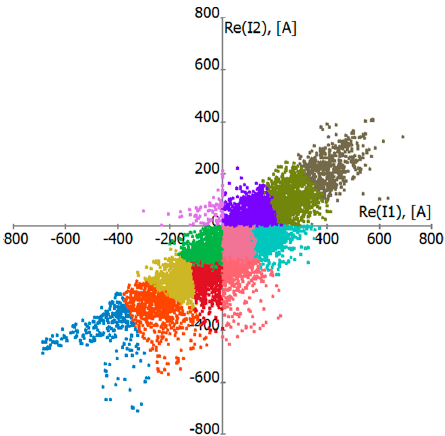
Figure 3. K-means-clusters for a 2 × 220 kV line with k = 12 clusters. Projection of the clusters on the plane of the active currents (i.e., real part of complex current). Points belonging to different clusters are distinguished by different